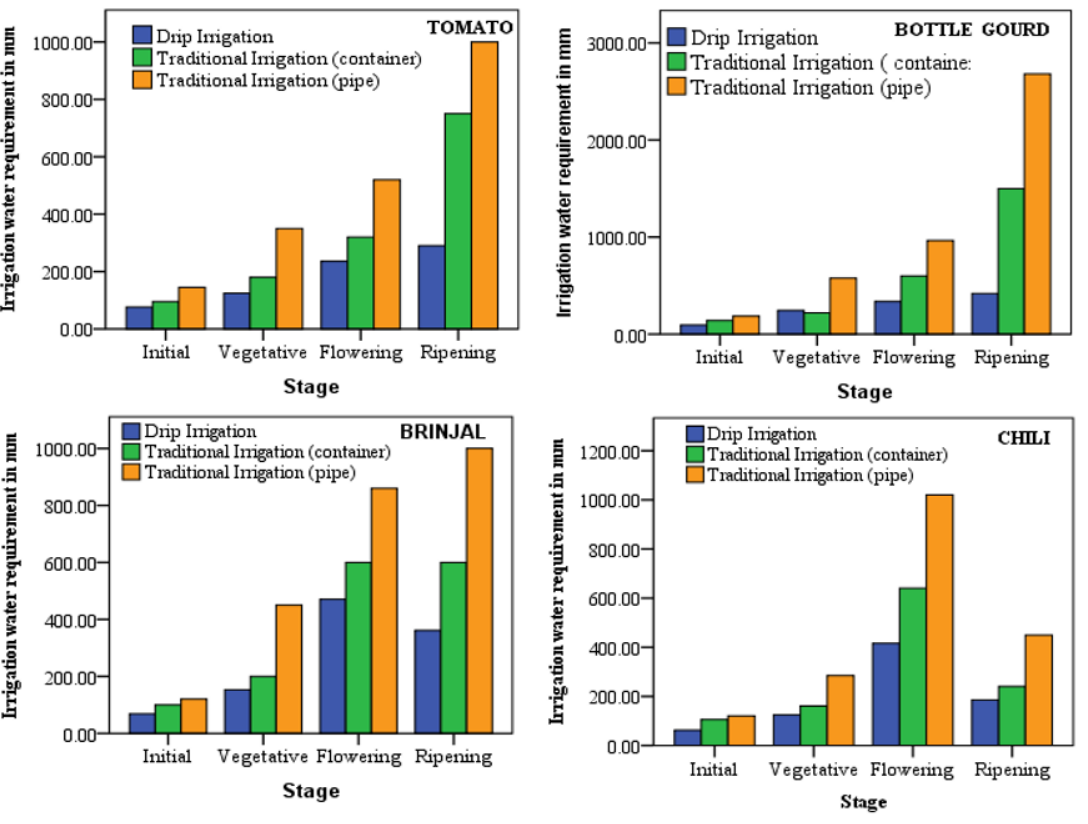
Figure 5. Irrigation water requirement at different stages of Bottle gourd, Tomato, Brinjal and Chili with drip irrigation and traditional irrigation (container, pipe with shower).